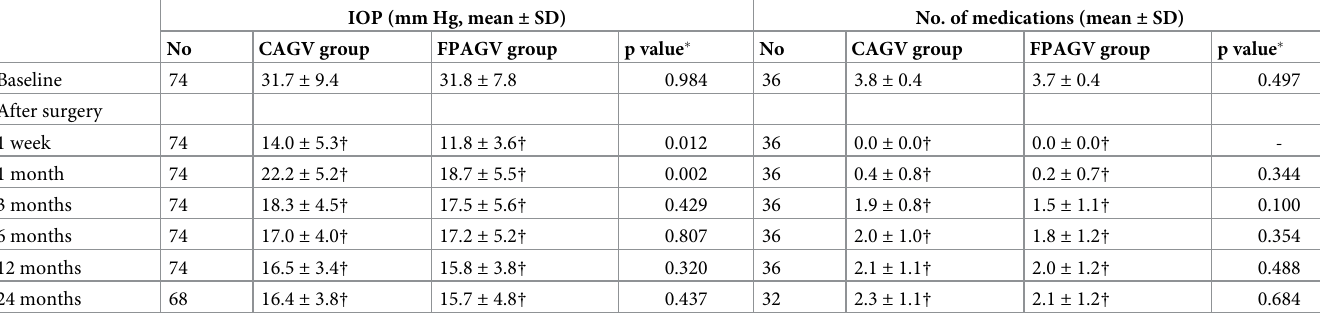
Table 2. Comparison of intraocular pressure and number of anti-glaucoma